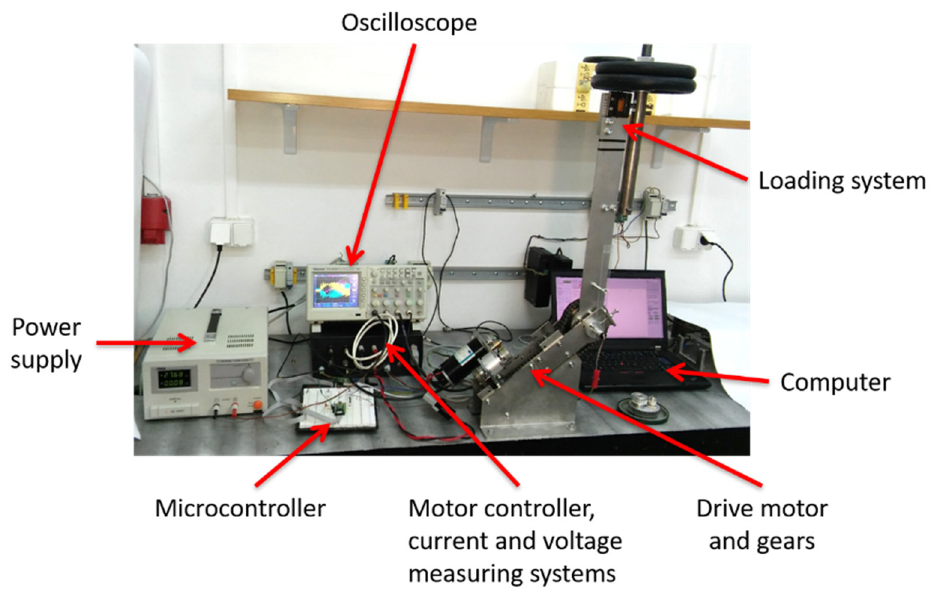
Figure 23. View of the tested drive system.